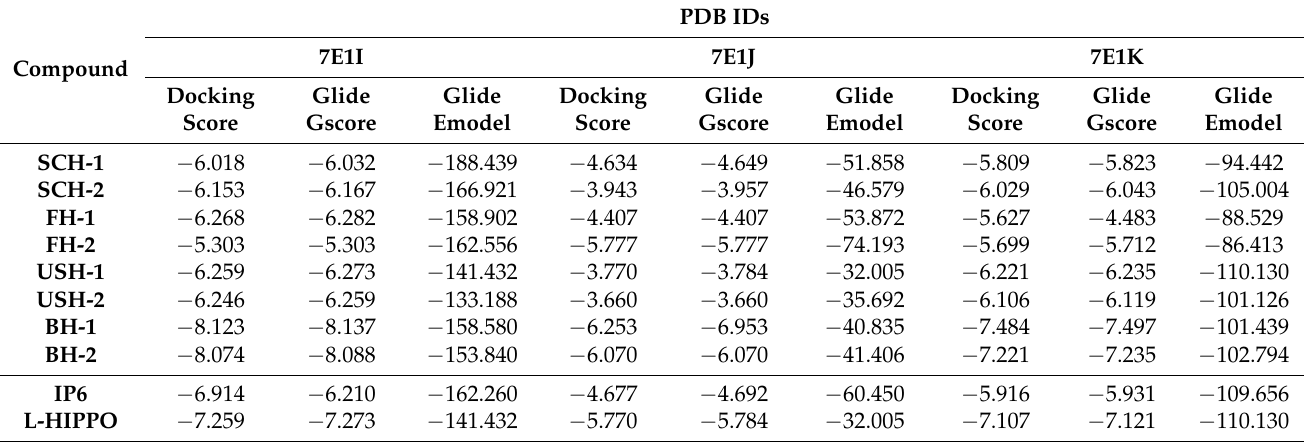
Figure 5. Docking poses of eight new L-HIPPO derivatives (yellow dashes: hydrogen bonding) in the MA domain (PDB ID: 7E1I) ( A ) Surface presentation. ( B ) Ribbon presentation. ( C ) Docking interactions of BH-1, BH-2, and L-HIPPO in the MA domain (PDB ID: 7E1I). Table 1. Docking score (kcal/mol), glide gscore (kcal/mol), and glide emodel (kcal/mol) results of eight new L ‐ HIPPO derivatives in the MA domain (PDB IDs: 7E1I, 7E1J, and 7E1K).